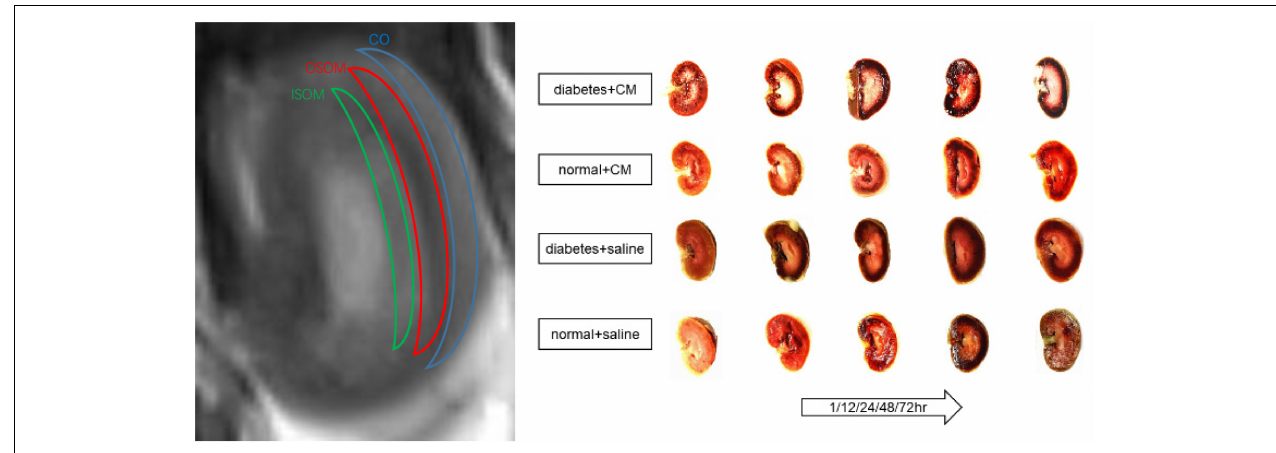
FIGURE 2 | ROI on T2WI and kidney coronal section. From outside to inside are cortex (CO), outer stripe of the outer medulla (OSOM), and inner stripe of the outer medulla (ISOM). Coronal section of kidney of each group at different times is shown. CM, contrast medium; T2WI, T2 weighted image; ROI, region of